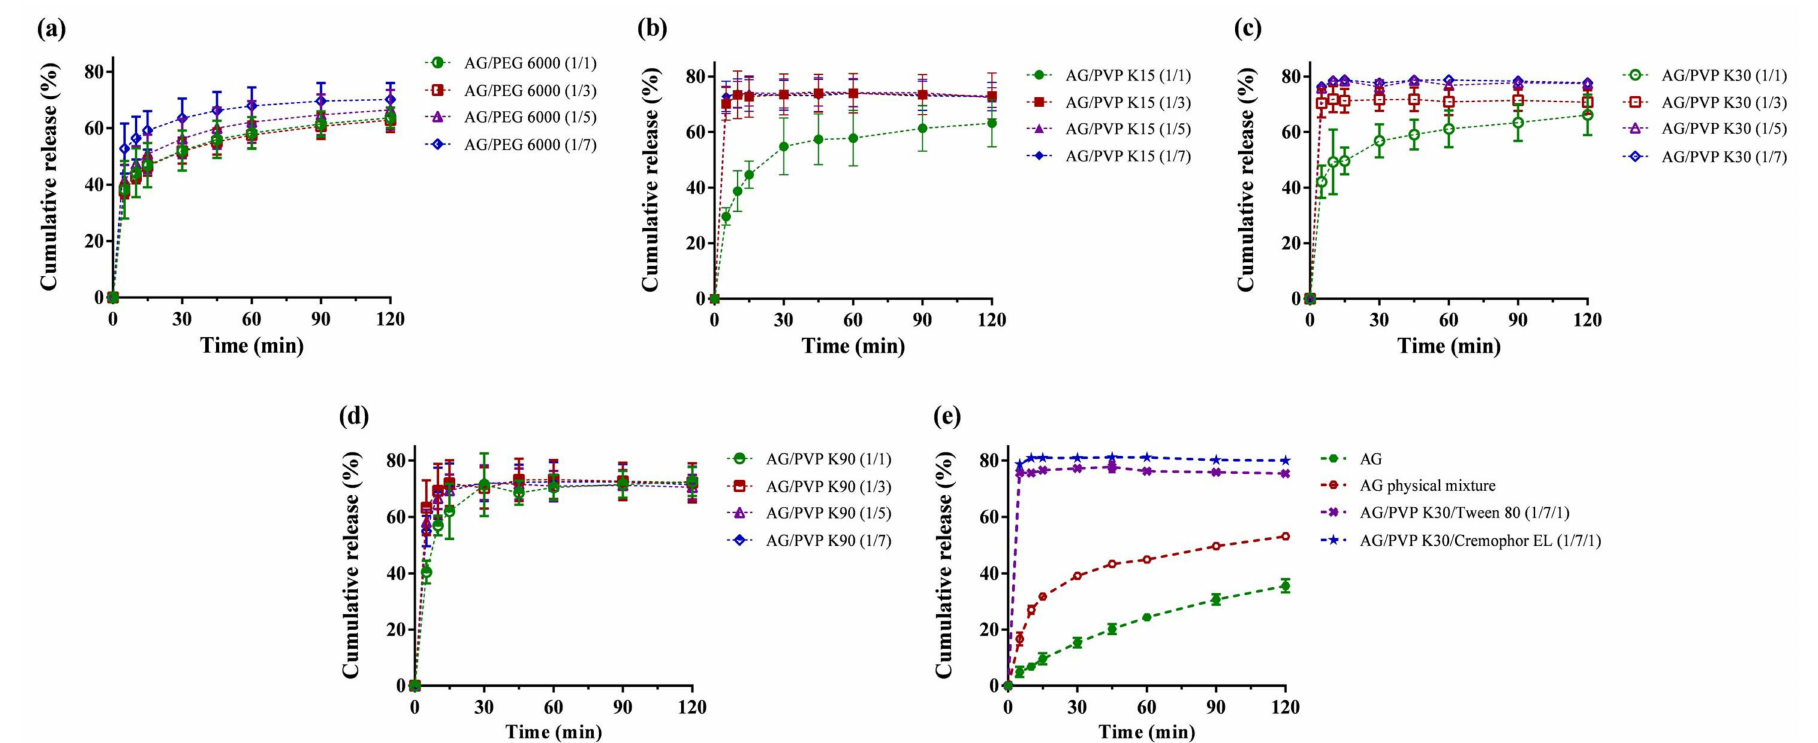
Figure 1. Dissolution profiles of andrographolide (AG) prepared using: ( a ) PEG 6000; ( b ) polyvinylpyrrolidone (PVP) K15; ( c ) PVP K30; ( d ) PVP K90; and ( e ) PVP K30 containing Tween 80 or Kolliphor EL as surfactant carrier. Data are presented as mean ± standard deviation ( n = 3 for each